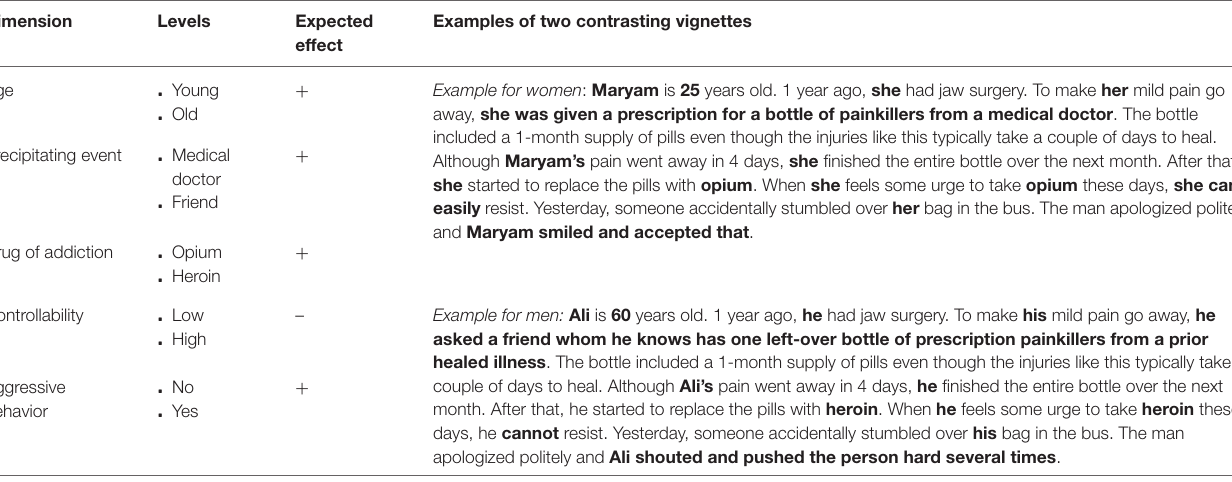
TABLE 1 | Description of the experimental variation of five vignette dimensions per gender ( N Vignettes = 32) and directions of the expected effects on stigma. Dimension